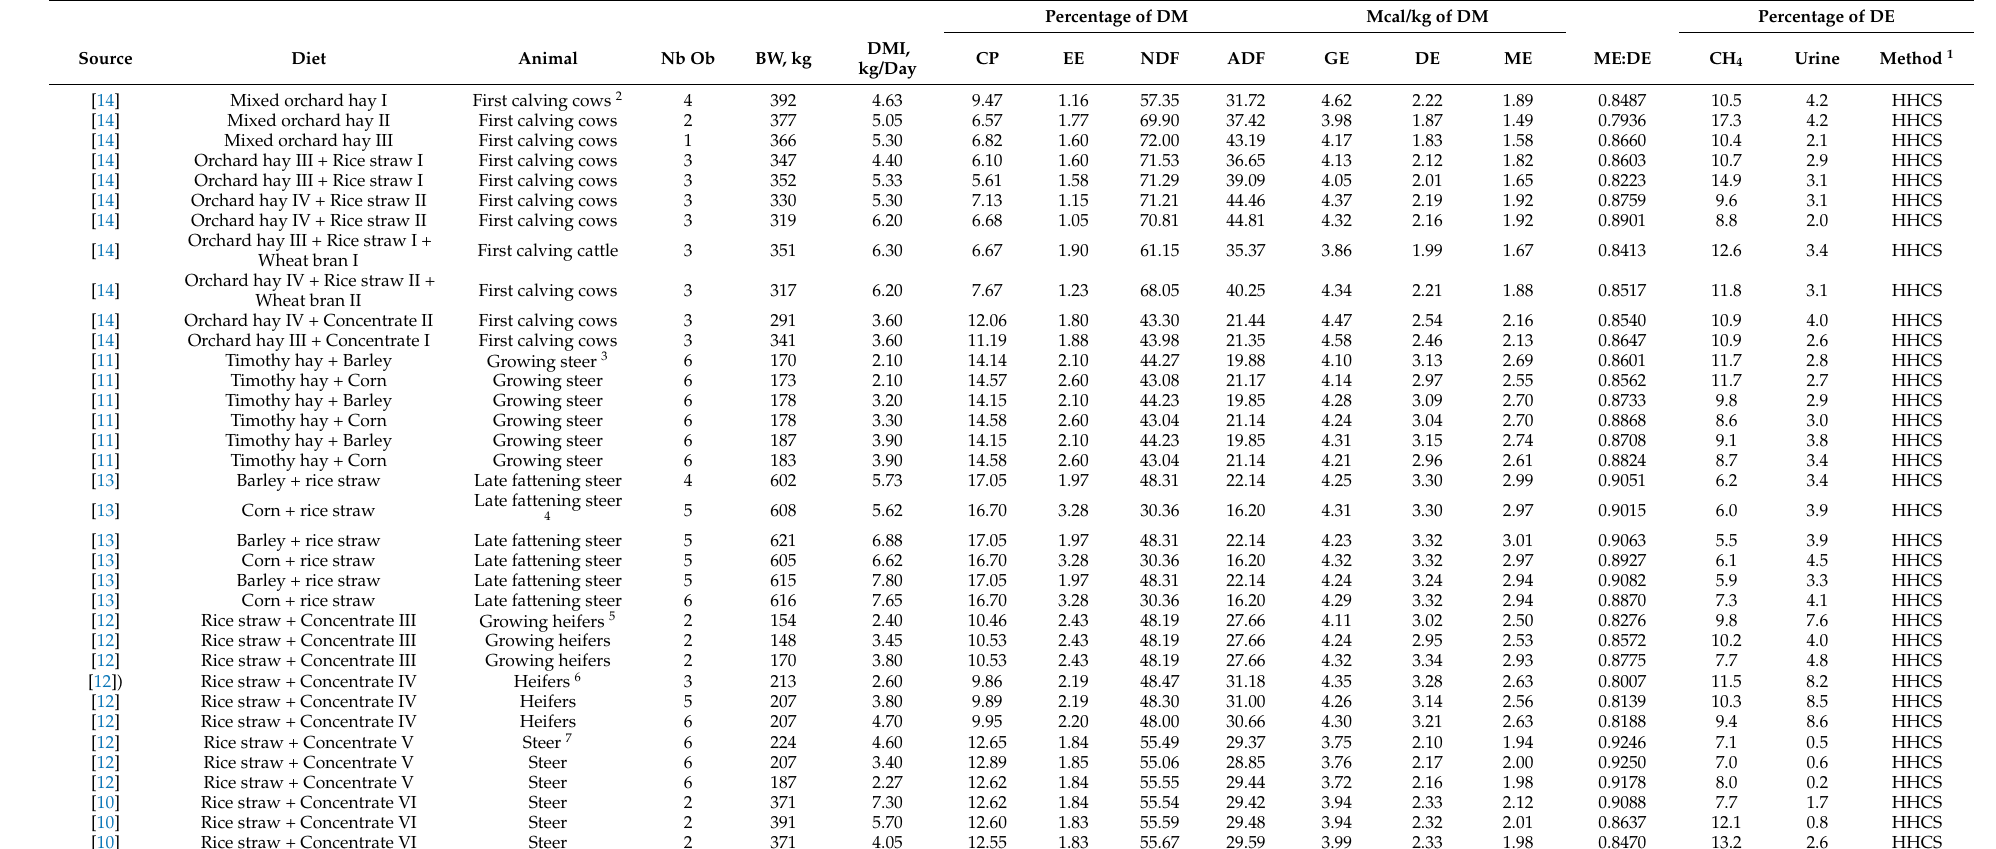
Table 1. Database of the average observations used for evaluation of the relationship between the DE and